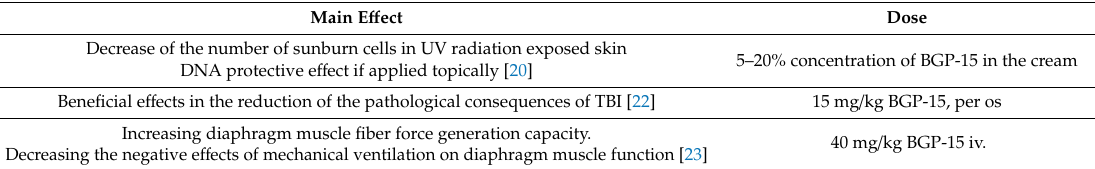
Table 7. Summary of the investigations related to the aforementioned e ff ects of BGP-15.